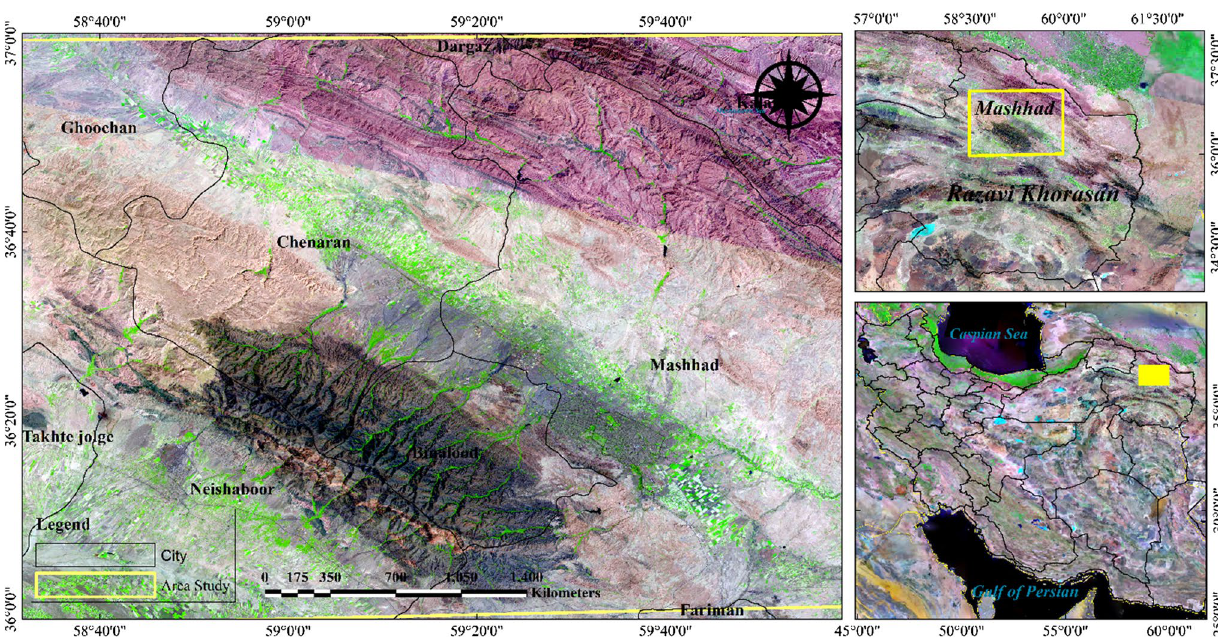
Fig. 1 Geographical coordinates of the area under